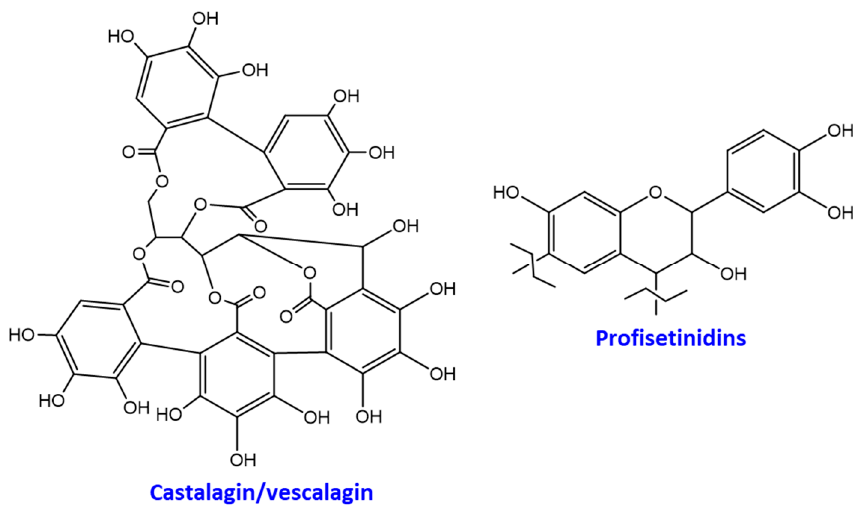
Figure 1. Representative structures of chestnut and quebracho tannins.